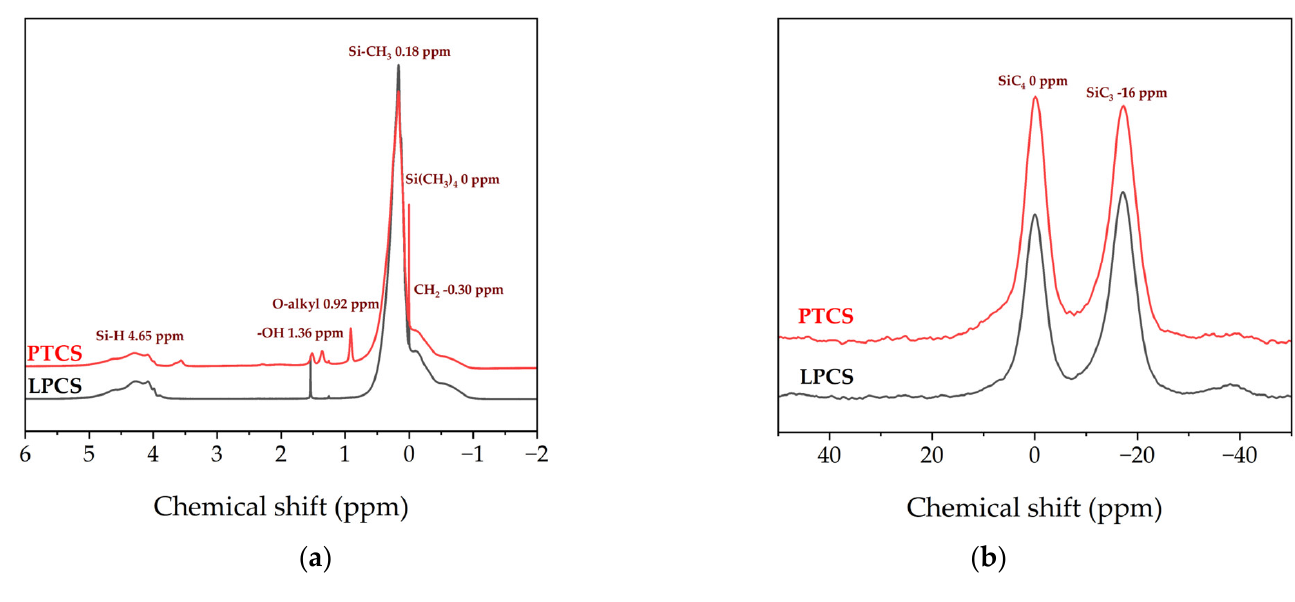
Figure 2. NMR spectra of LPCS and PTCS: ( a ) 1 H NMR; ( b ) 29 Si NMR.